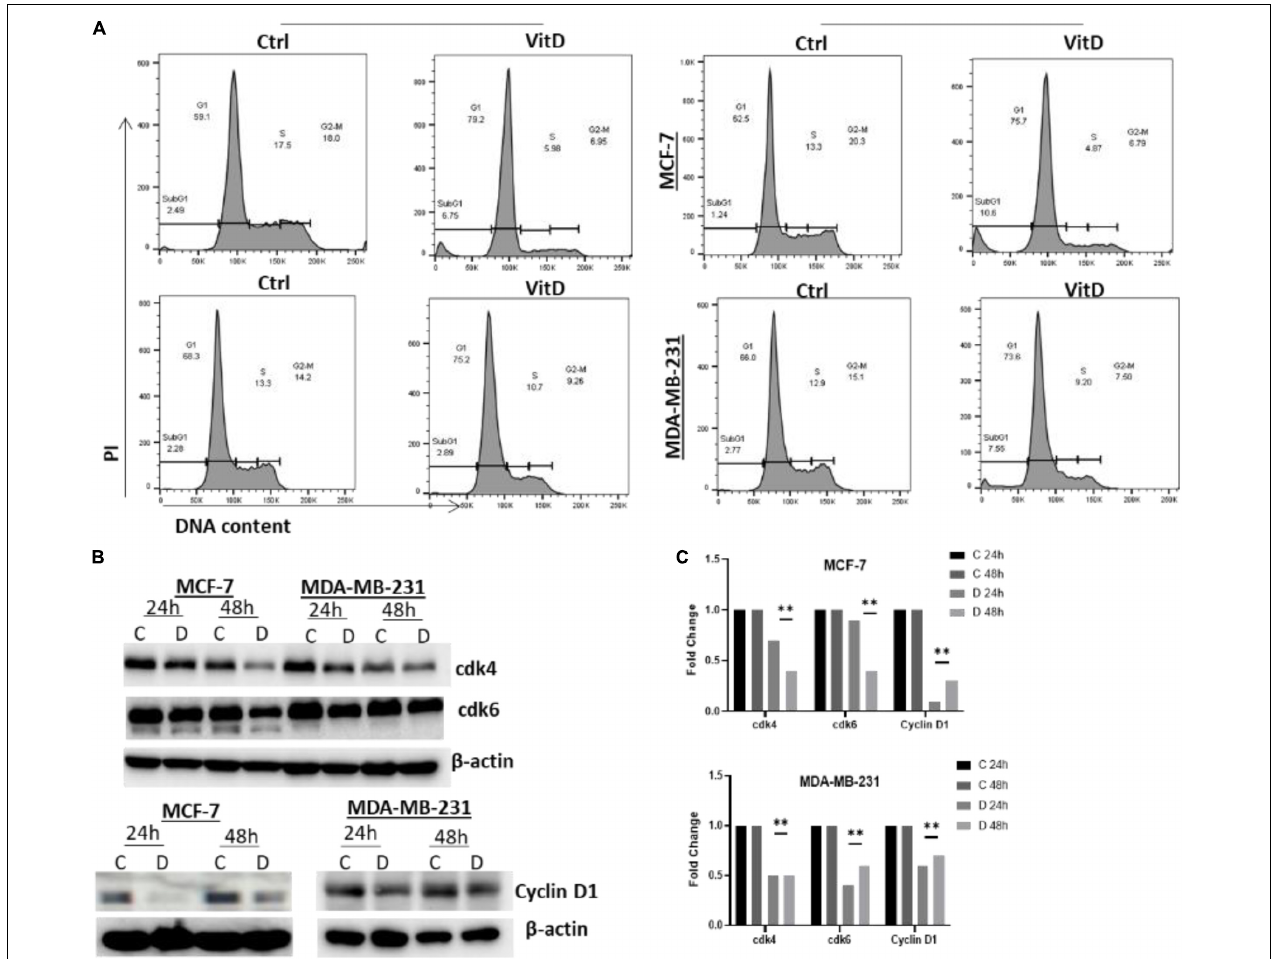
FIGURE 7 | Vitamin D treatment leads to cell cycle arrest at G1/S phase arrests in BRCA cells. (A) Cells treated with 10 µ M vitamin D for 24 and 48 h as well as PI stain were used for untreated controls and analyzed. (B) cdk4 (U/mg protein), cdk6 (U/mg protein), and cyclin D1 (U/mg protein) were assayed for control, and MCF-7 and MDA-MB-231 cells treated with 10 µ M of vitamin D for 24 and 48 h. (C) Quantitative analysis of relative protein band density after normalization to β -actin and compared to the control. **Represents statistically significant change ( P <